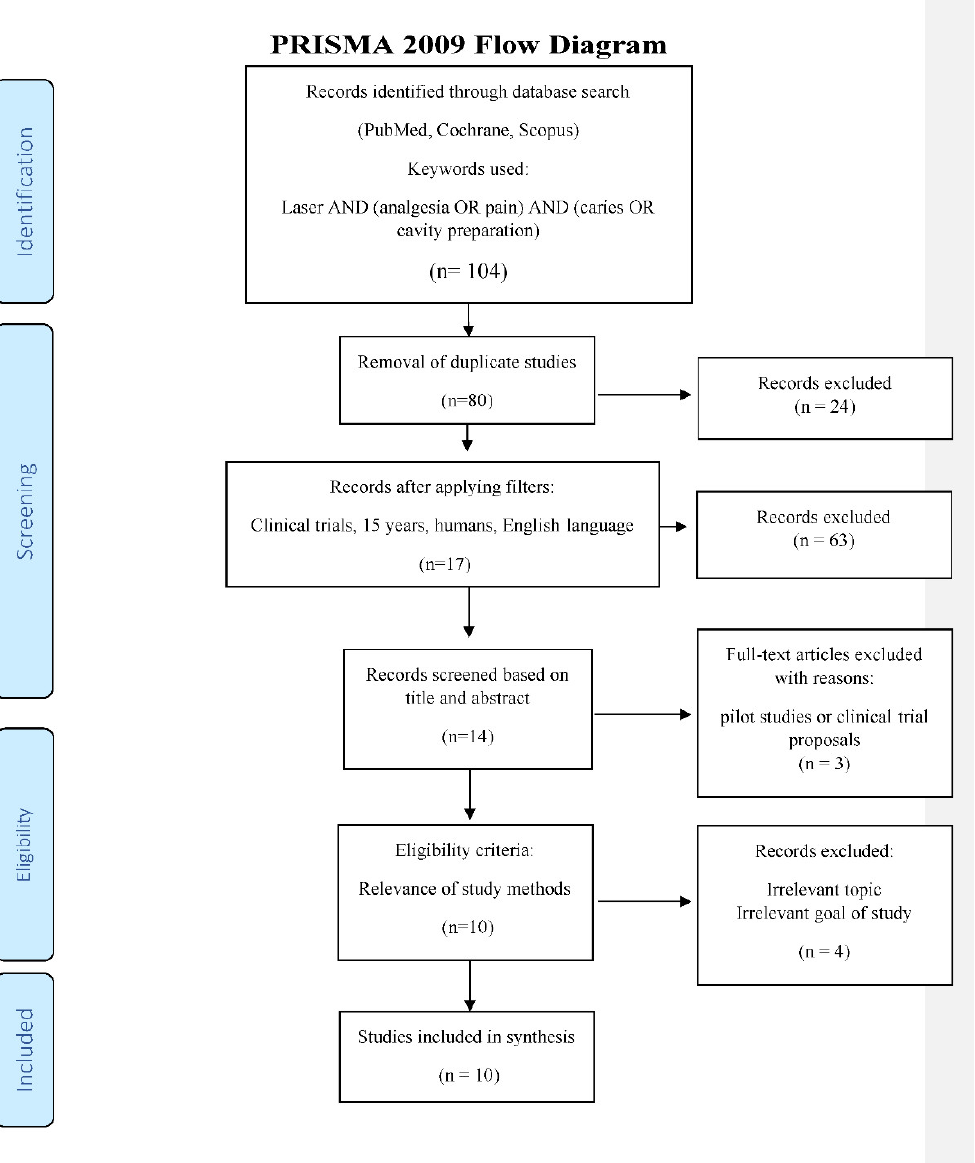
Figure 1. PRISMA flow-chart of selected criteria for the included article reports.